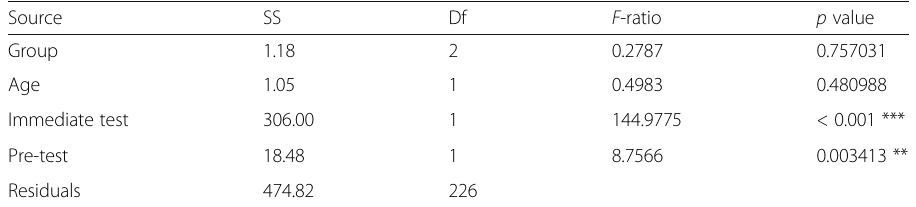
Table 19 Analysis of variance (ANOVA) type II result for immediate test, delayed test and pre-test Source SS Df F -ratio p value